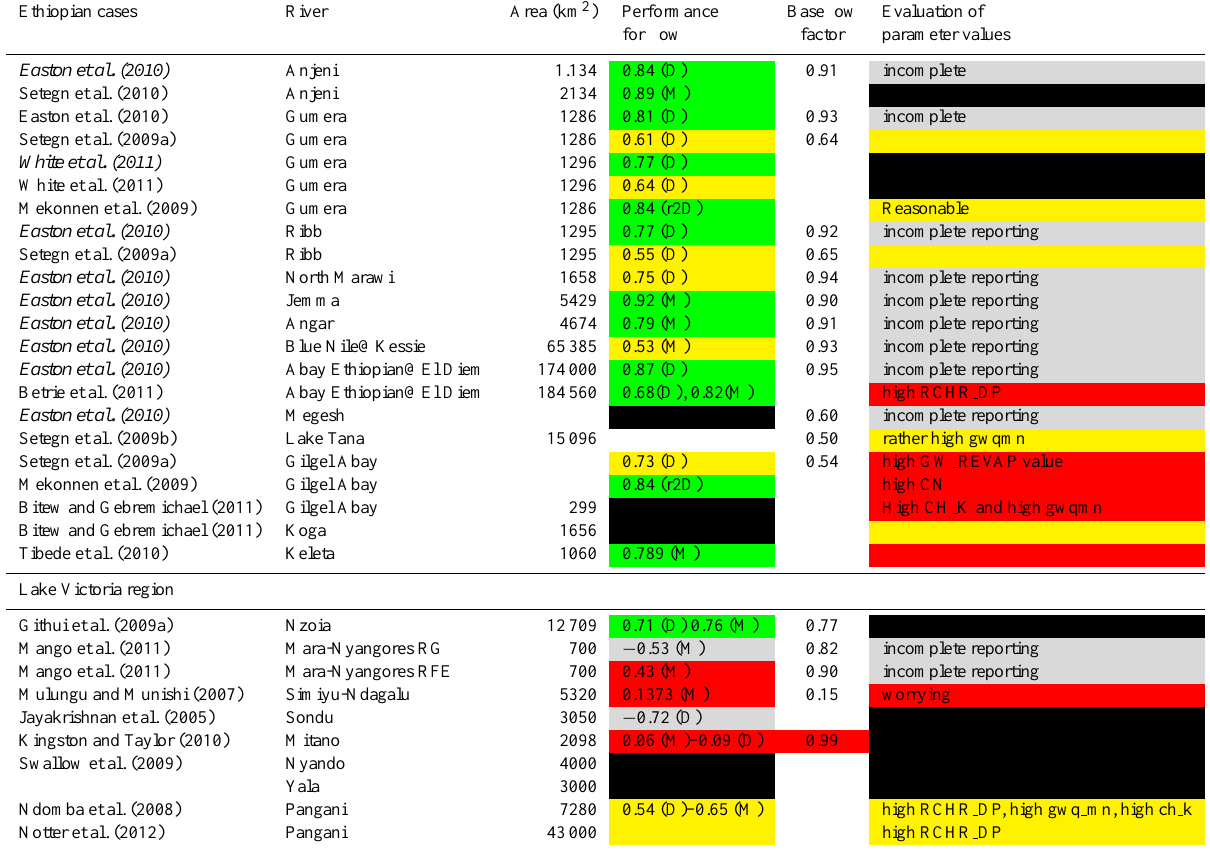
for flow parameter values